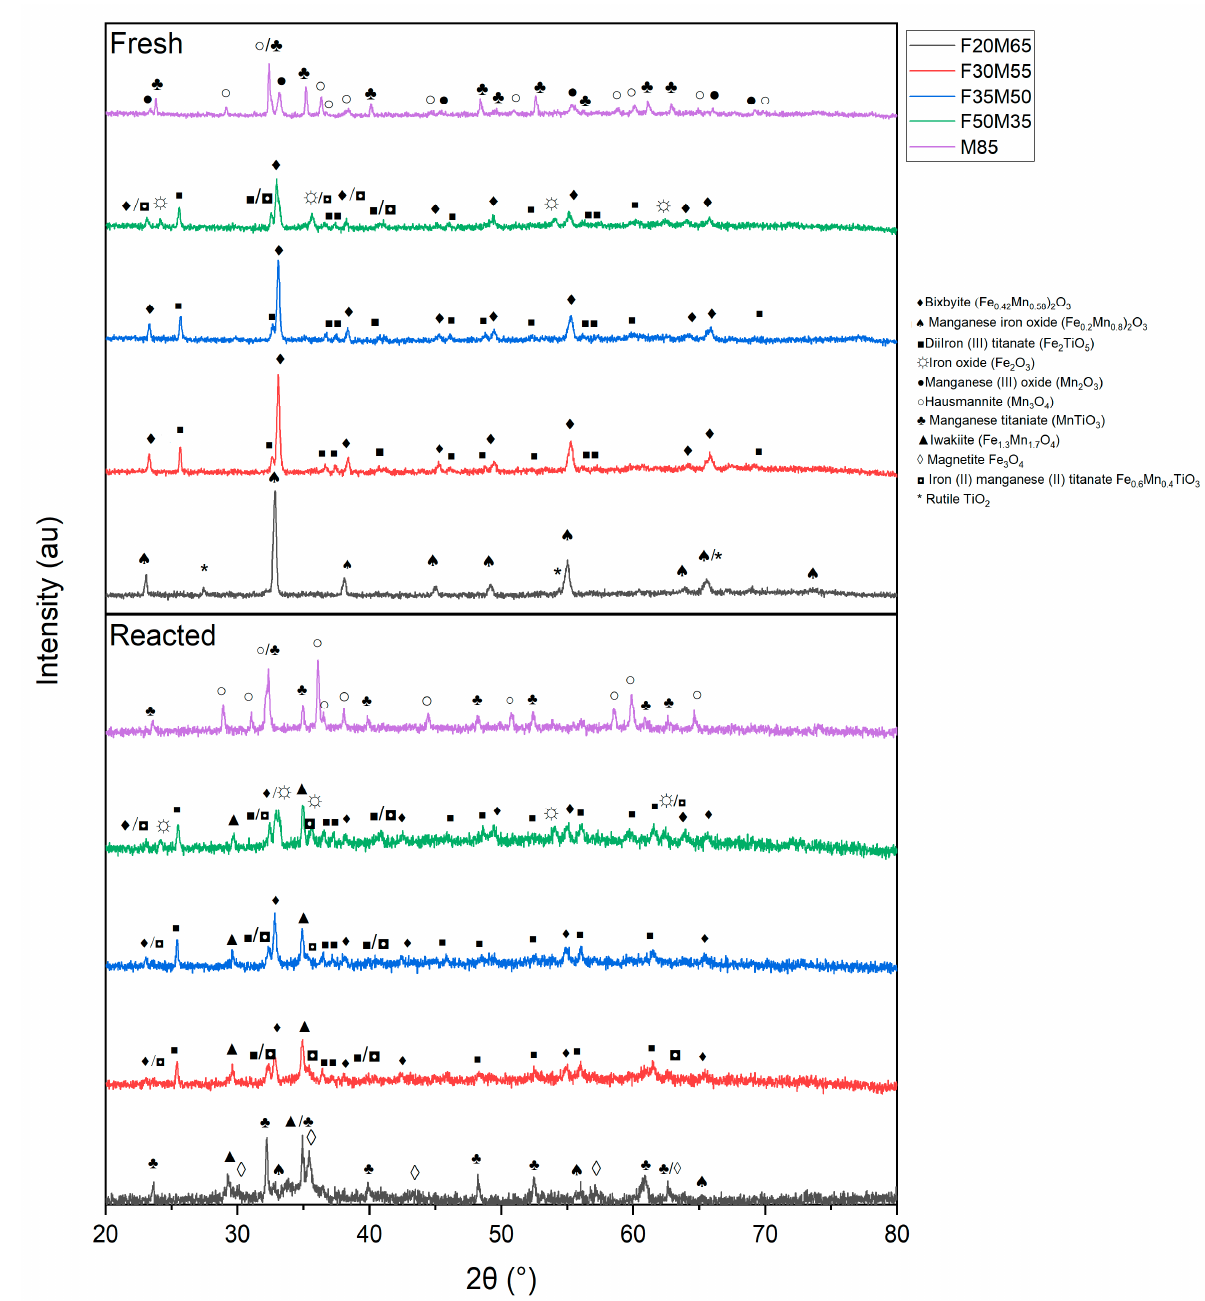
Figure 1. Comparison of X-ray diffraction pattern between fresh and reacted samples.